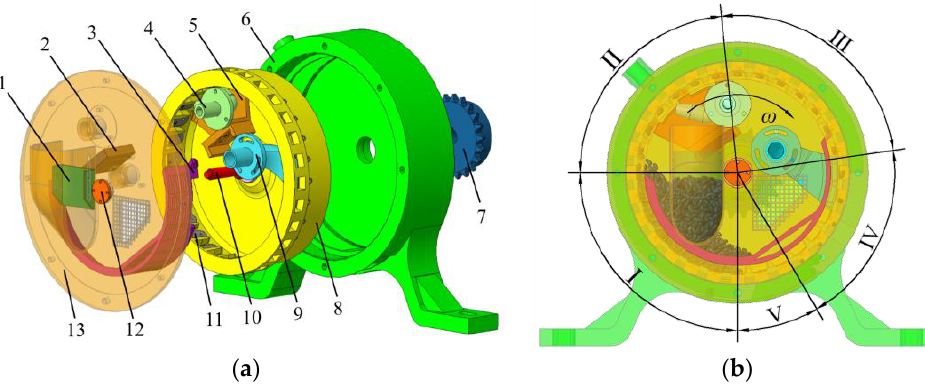
Figure 1. Structural schematic diagram of seed-metering device: ( a ) decomposition view and ( b ) schematic representation of operating process division. (1) Adjusting plate, (2) scraper foundation, (3) baffle, (4) seed-disturbing air nozzle, (5) seed-cleaning scraper, (6) back shell, (7) chain wheel, (8) seeding plate, (9) seed-throwing air nozzle, (10) seeding shaft, (11) replacement board, (12) end cap, (13) fore shell. ( Ⅰ ) Seed-filling zone, ( Ⅱ ) seed-cleaning zone, ( Ⅲ ) seed-carrying zone, ( Ⅳ ) primary seed-throwing zone, and ( Ⅴ ) secondary seed-throwing zone.